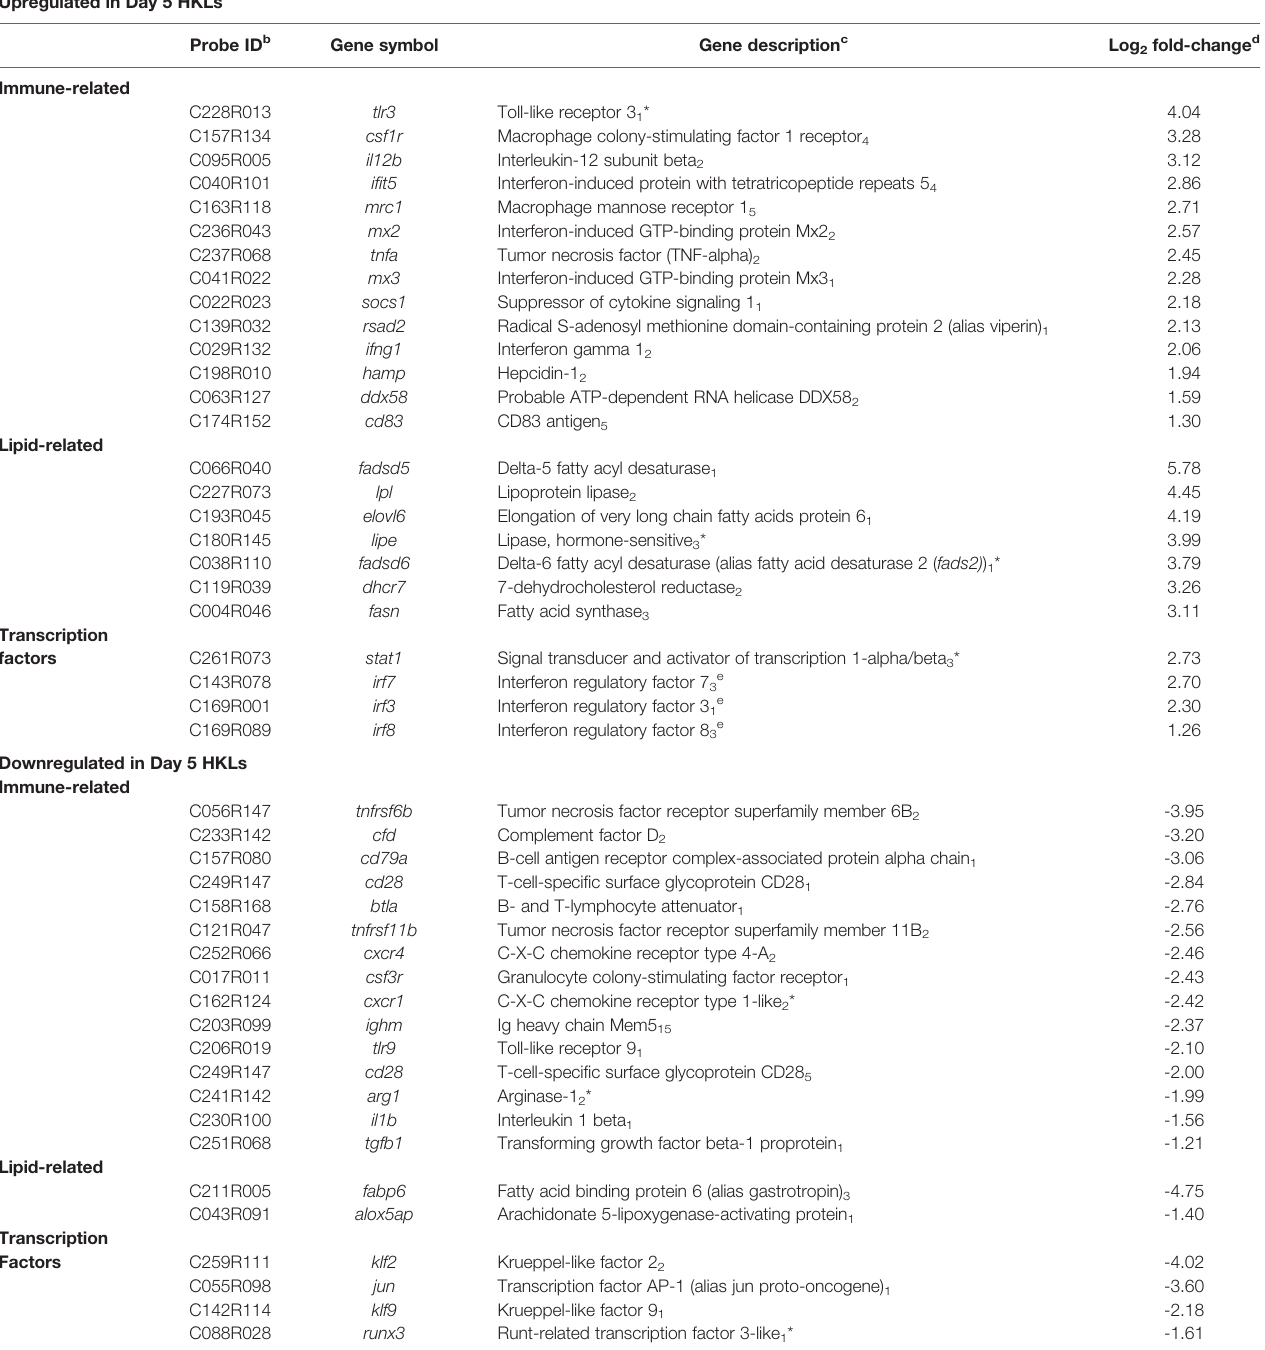
TABLE 1 | Selected a probes differentially expressed between Day 1 and Day 5 HKLs. Upregulated in Day 5